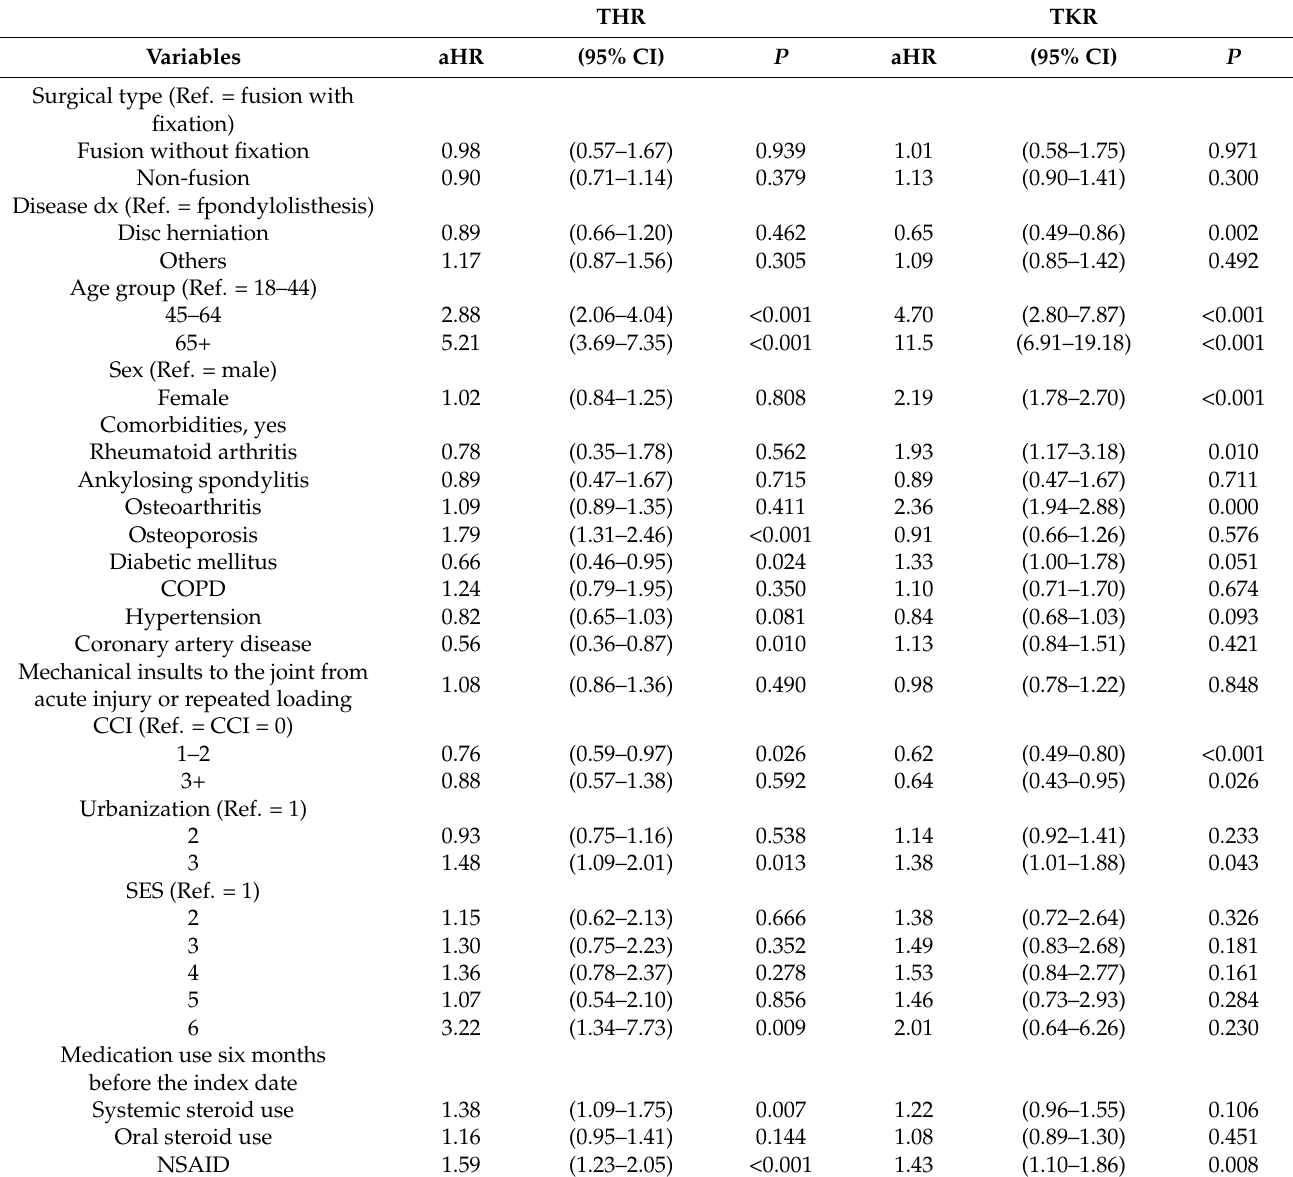
Table 4. Factors associated with the risk of 1-year total hip replacement and total knee replacement based on multivariate Cox regression